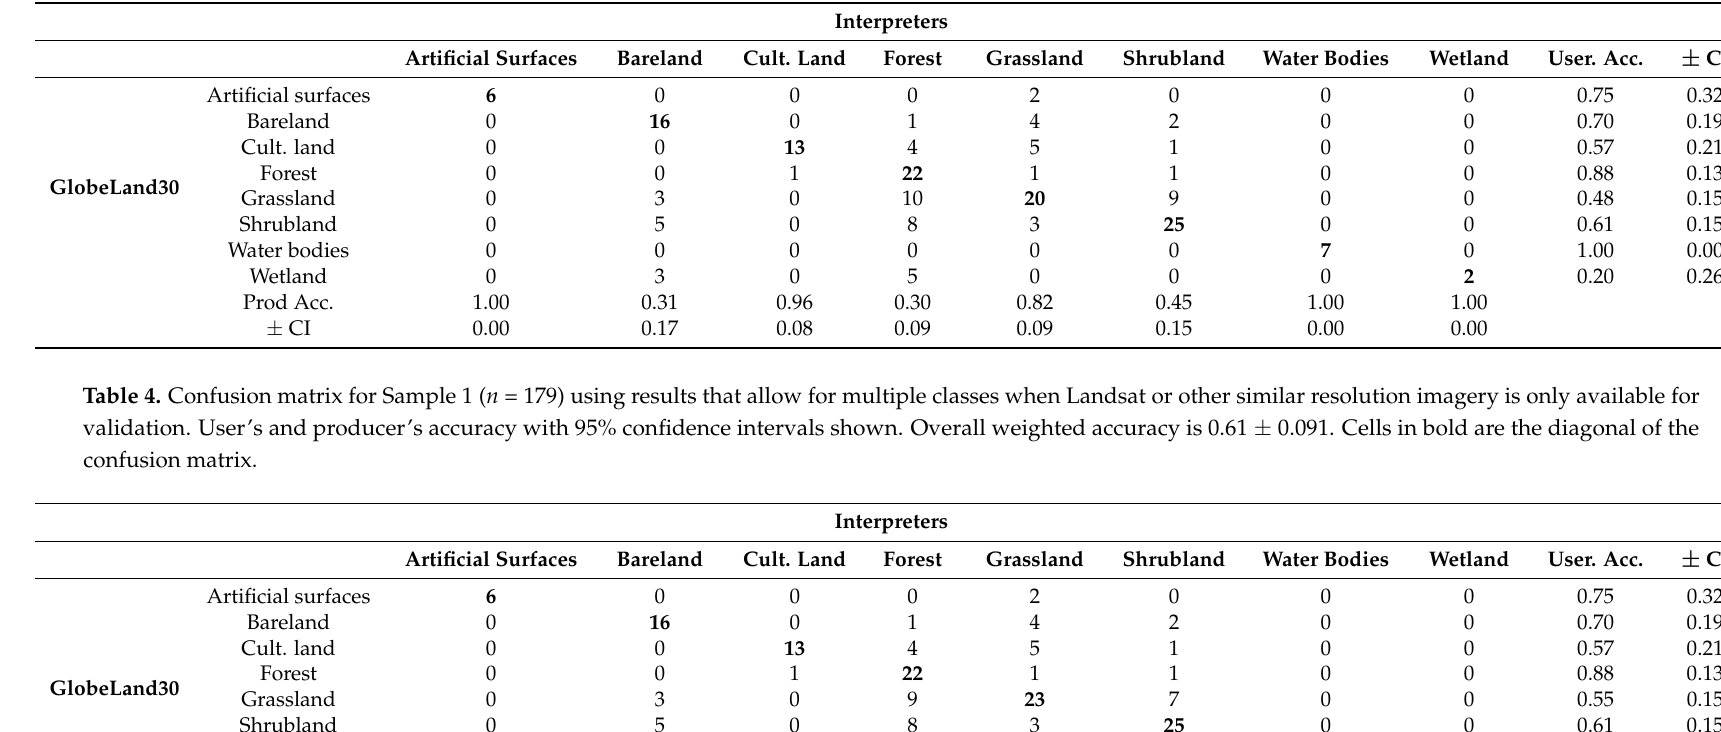
Table 3. Confusion matrix for Sample 1 ( n = 179) considering either choice 1 or choice 2 when present (which occurred in 12.8% of the sample). User’s and producer’s